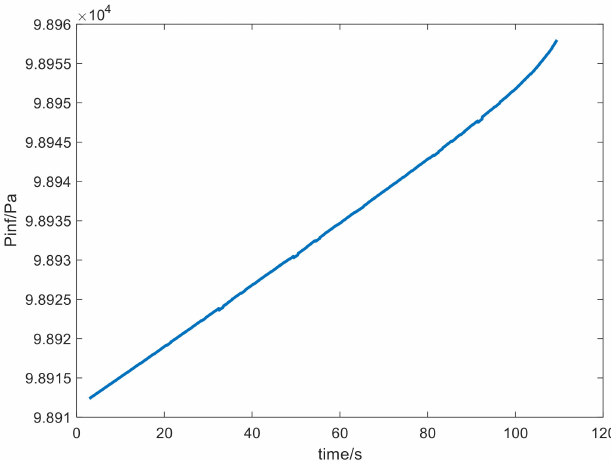
Figure 27. Calculated static pressure results. As shown in Figures 21–23, the abscissa represents time and the ordinate represents the pressure value. ExperimentalData represents the measured data, while FittedLine represents the line fitted by a one-time polynomial. P1, p3, and p5 represent lines